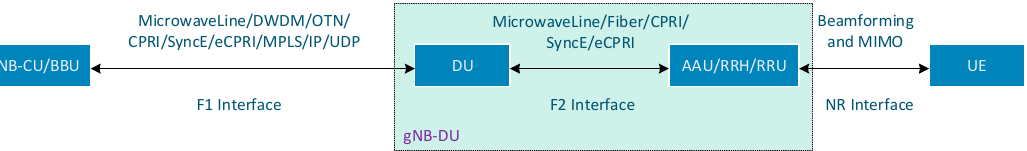
Figure 6. Transport technologies used in the F1 and F2 interfaces of fronthaul/midhaul as a components of the stationary part of NG-RAN (MicrowaveLine is the wireless transport option between gNB-CU/BBU and gNB-DUs/RRHs—wireless communication between gNB-DUs/RRHs is also possible – out of the scope of analysis).